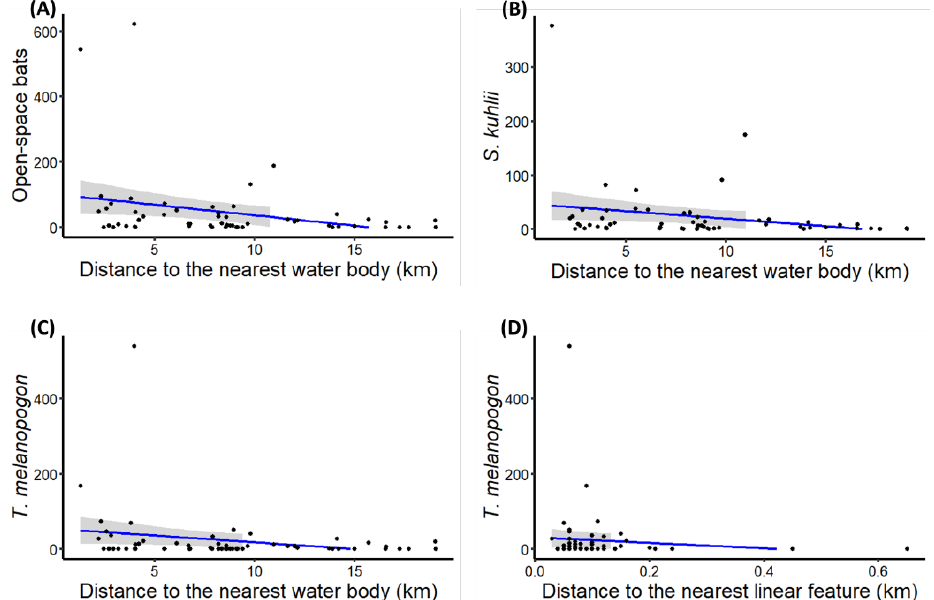
Figure 6. Effects of significant landscape factors on open-space foraging bats. Distance to the nearest water body had a significant negative effect on the activity of open-space foraging bats ( A ) and S. kuhlii ( B ), while two landscape factors, namely distance to the nearest water body ( C ) and distance to the nearest linear feature ( D ), had a significant negative effect on T. melanopogon activity. All regressions are plotted with 95% confidence